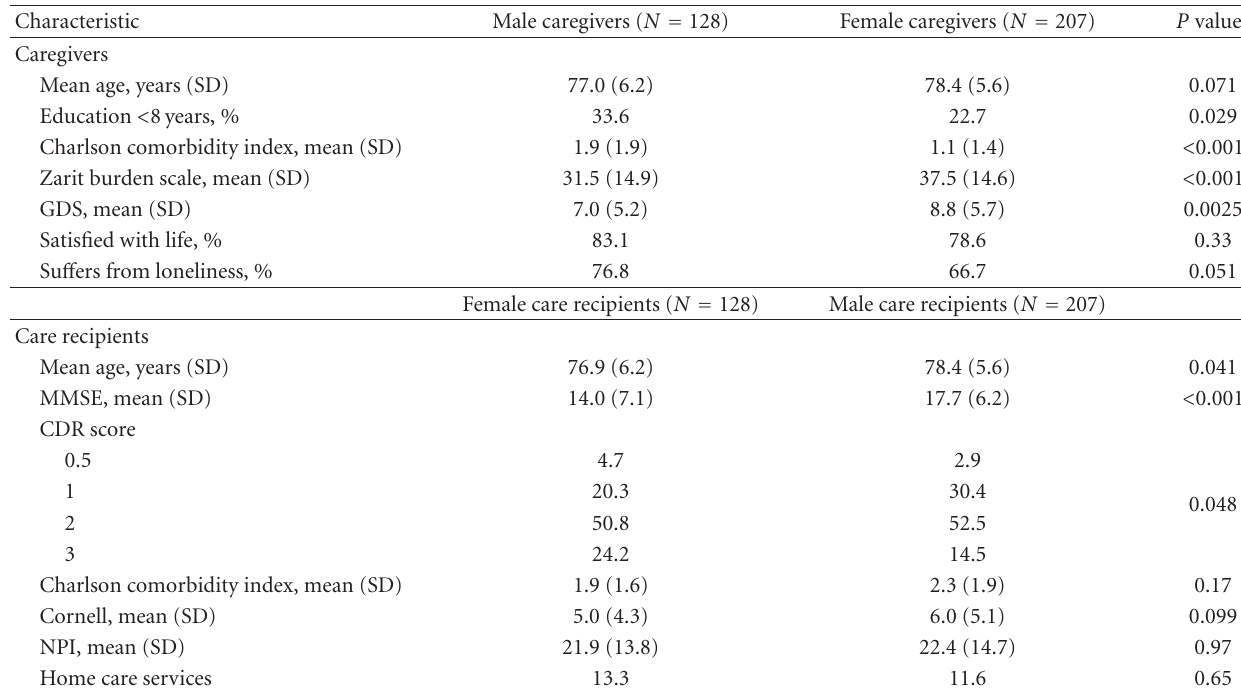
Table 1: Characteristics of caregivers and care recipients with dementia according to gender. Characteristic